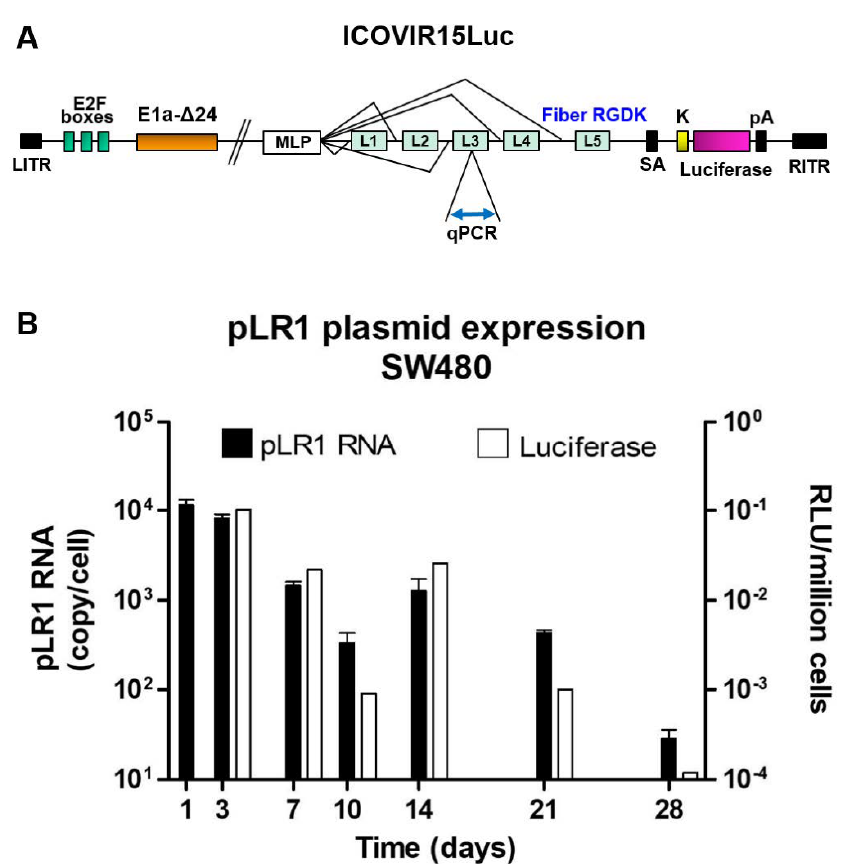
Figure 6. ( A ) Scheme of ICOVIR15Luc encoded by pLR1 plasmid. qPCR indicates the location of the target sequence for the quantitative polymerase chain reaction on the Ad5 hexon gene, present within late transcription unit 3 (L3). LITR: left inverted terminal repeat; E2F boxes: locations for E2F